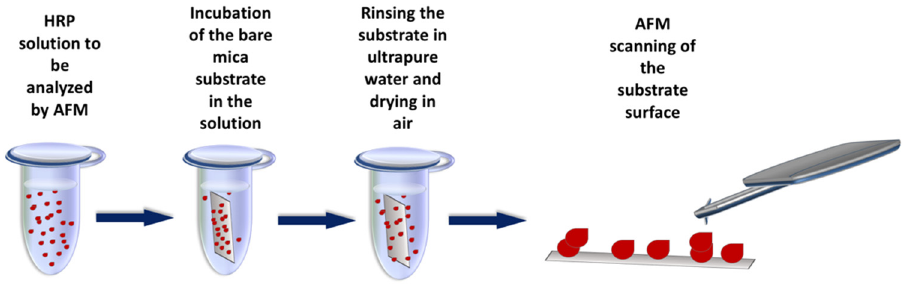
Figure 2. Schematic illustration of the direct surface adsorption of HRP from its aqueous solutions on mica substrates to study its adsorption using AFM.